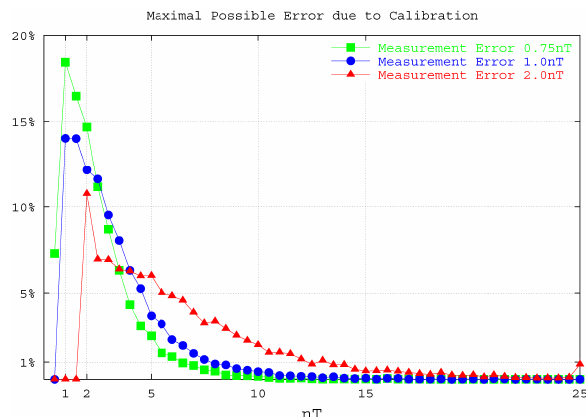
Fig. 6. Sequential observations of the maximal possible calibration error for CLF data, during the year 1999; the value εb is supposed to be 1nT. The largest values are associated with known magnetic storms of the year 1999 as those of 13 January, 18 February, or 20 October.